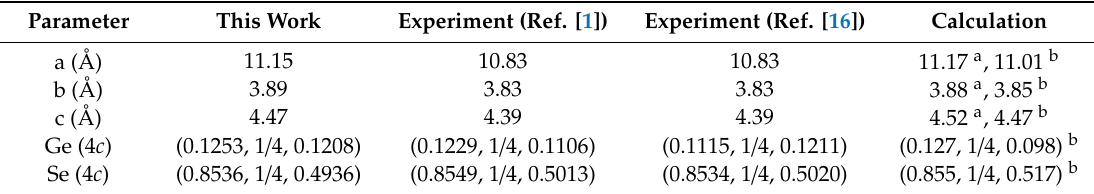
Table 1. Crystallographic data for Pnma GeSe under zero